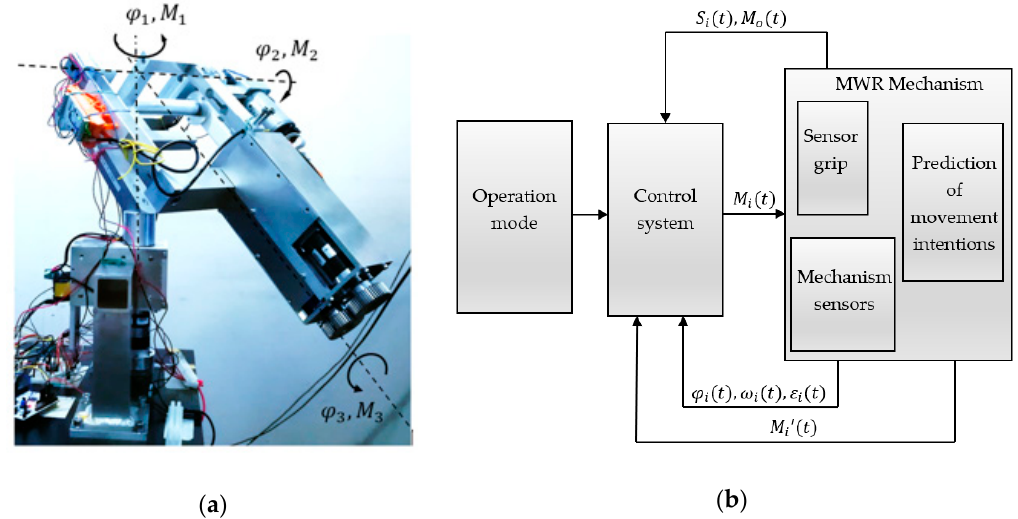
Figure 8. The developed prototype of MWR mechanism: ( a ) view of the MWR prototype; ( b ) control diagram of the MWR mechanism.